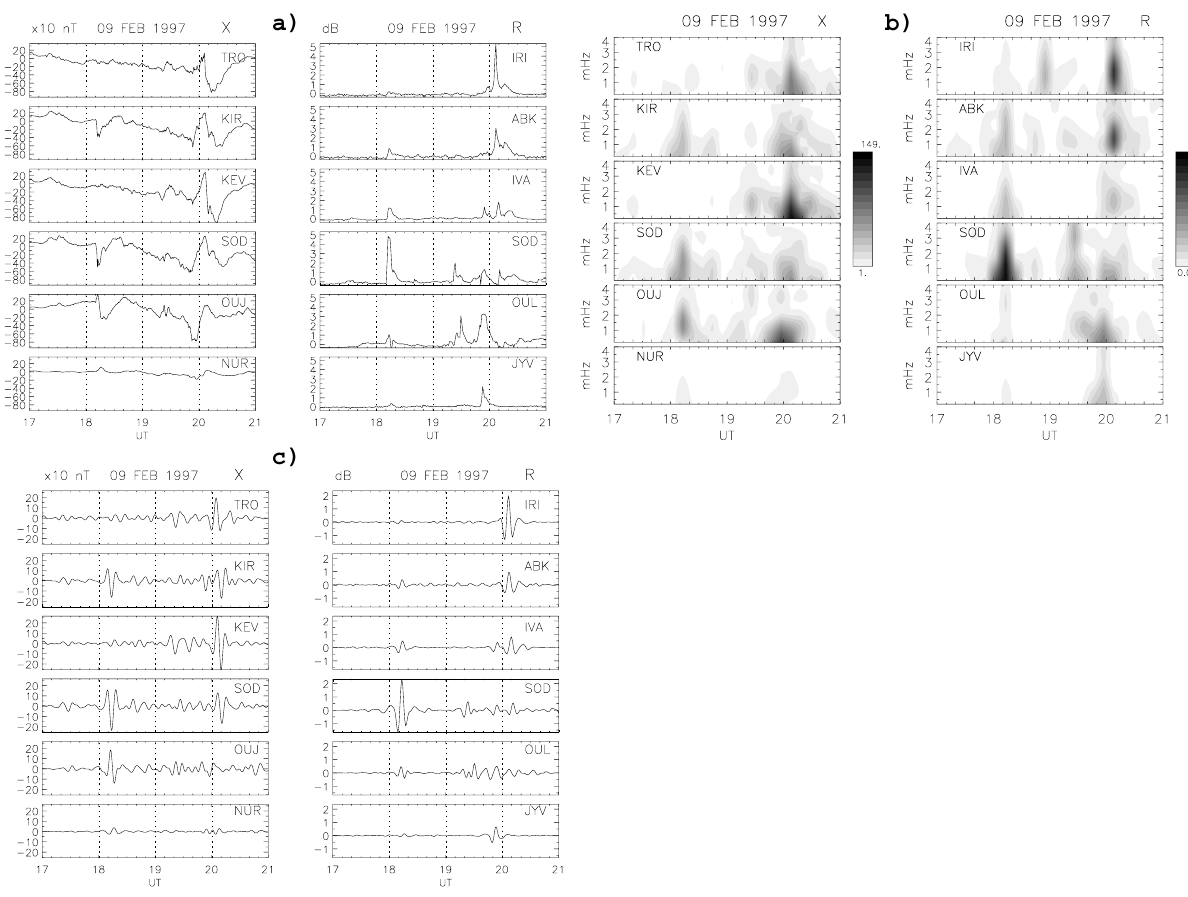
Fig. 4. The magnetic X -component and riometer data: raw records (panel a ), their dynamic spectra in the frequency range of 0.5–4.0MHz (panel b ) and 1–3MHz filtered data (panel c ), recorded at the IMAGE and riometer stations shown in Fig. 1.